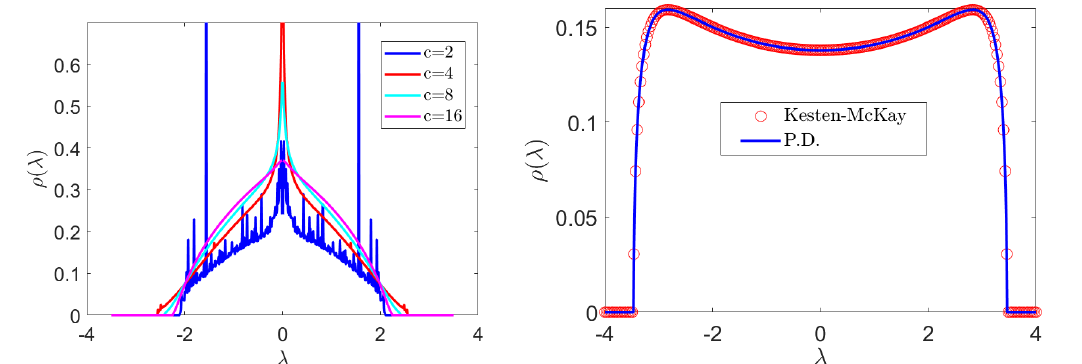
Figure 5: Left : spectral density of adjacency matrices of ER graphs with Gaussian bond weights with zero mean and variance 1 / c , for growing values of c , obtained with population dynamics algorithm using a regulariser (cid:34) = 10 − 300 to highlight the continuous part of the spectrum. Right : spectral density of adjacency matrices of random regular graphs with coordination c = 4. The population dynamics result (solid blue line) is compared to the analytical expression of the spectral density, found in [ 45,46 ] , known as Kesten-McKay pdf (red